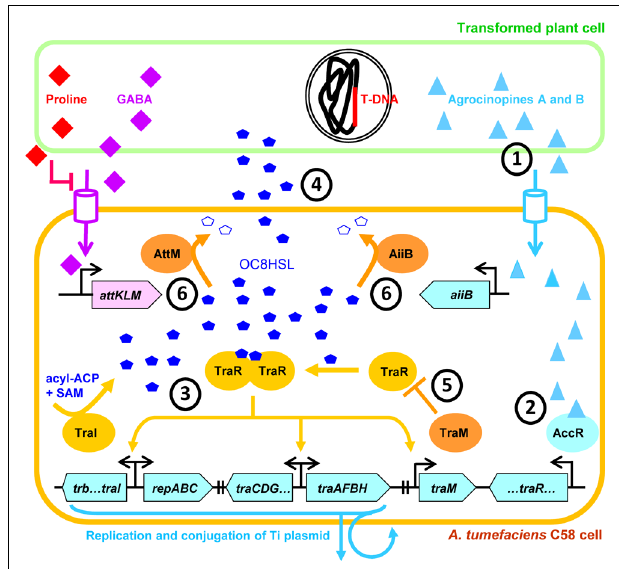
FIGURE 4 | Representation of the sophisticated hierarchical QS regulation in A. tumefaciens strain C58. QS-dependent conjugation and copy-number amplification of theTi plasmid is initiated when OC8HSL and TraR reach appropriate concentration and form transcriptional active dimers. QS-signaling is positively regulated by the conjugal opines agrocinopines which are produced by the transformed plant cells (1) and induce production ofTraR by releasing AccR repressive action (2) .Then, active TraR-OC8HSL dimers activate the production ofTraI, thereby triggering a positive feedback in the synthesis of OC8HSLs (3) which are diffusible molecules (4) .The QS activation is delayed by theTraR-antagonistTraM (5) , as well as OC8HSL-cleaving lactonases AiiB and AttM (6) whose expressions are controlled by agrocinopines and GABA, respectively. SAM, S -adenosylmethionine; ACP, acyl carrier protein.TheTi plasmid genes and the At plasmid genes are in blue and pink boxes,